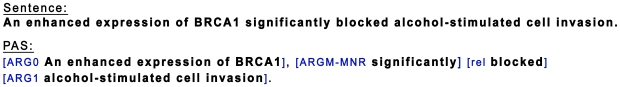
Biomedical sentence and one corresponding PAS for the verb ‘blocked’.A sentence annotated by SENNA with semantic, PropBank conforming roles. ARG0: The subject phrase of the verb/the blocker; ARG1: the argument role of the verb, the thing blocked; rel: the verb; ARGM-MNR: modifier argument for manner.